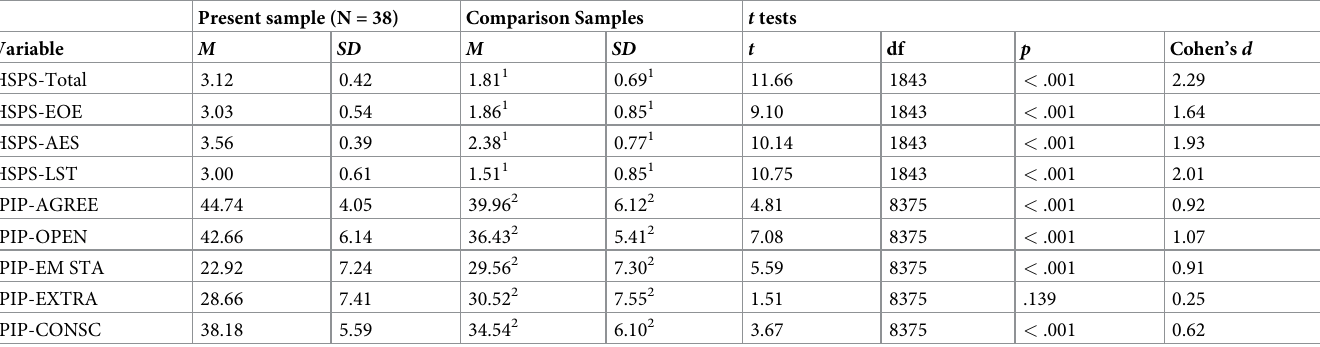
Table 1. Descriptive statistics of the present sample and comparison samples. Present sample (N =